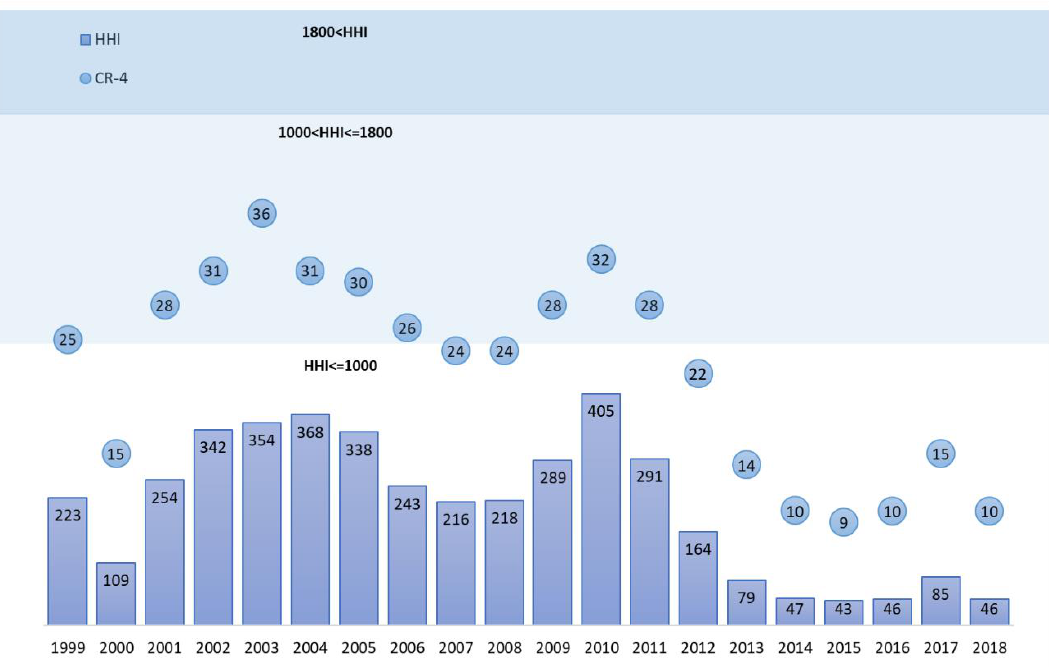
Figure 3. Russian tourism industry and Herfindahl – Hirschman Index (HHI).